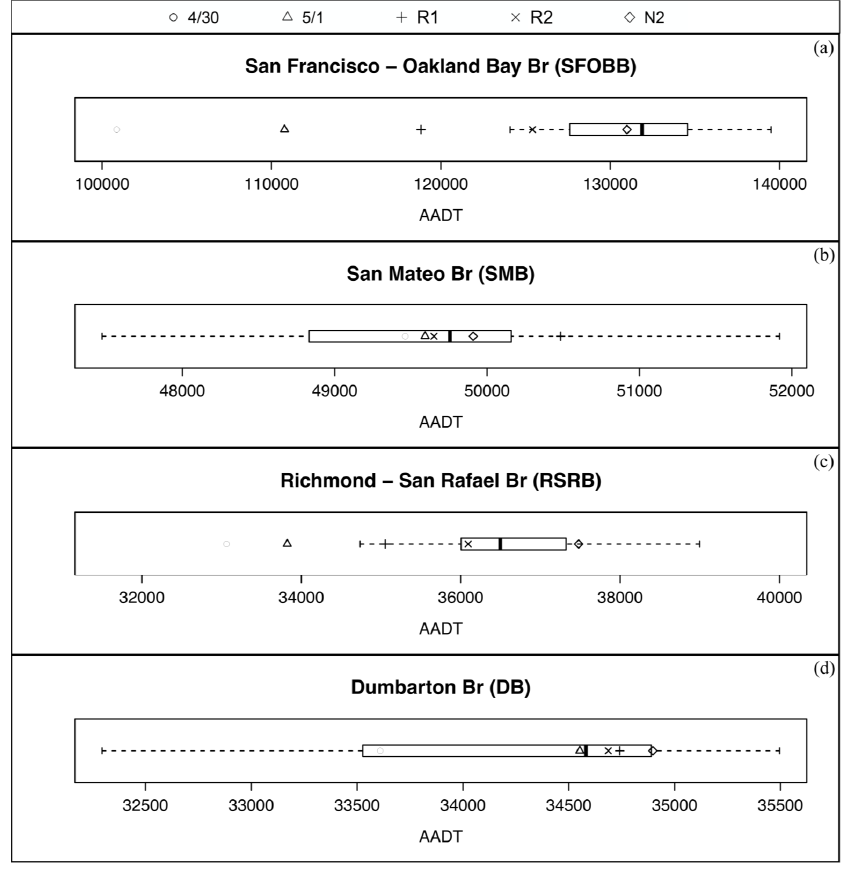
Figure 6. ( a ) Box plot of the weekday AADT at the SFOBB toll plaza and the AADT observed after Maze Meltdown; ( b ) box plot of the weekday AADT at the SMB toll plaza and the AADT observed after Maze Meltdown; ( c ) box plot of the weekday AADT at the RSRB toll plaza and the AADT observed after Maze Meltdown; and ( d ) box plot of the weekday AADT at the DB toll plaza and the AADT observed after Maze Meltdown.